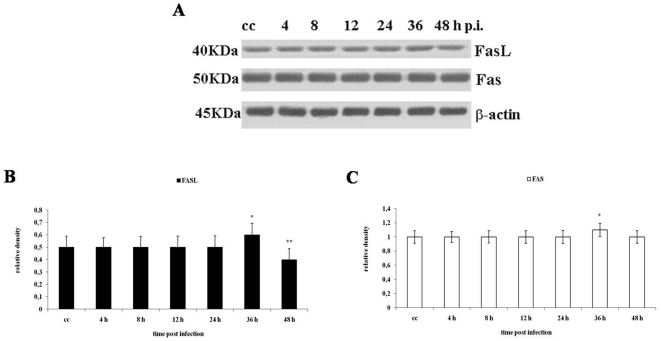
CCoV-II infection modulates FasL/Fas proteins expression.(A) Cell lysates were collected at the indicated times p.i., and equal amounts of proteins from each sample were subjected to Western blot analysis and probed for FasL and Fas. β-actin was used as a loading control. The molecular weight (KDa) of protein size standards is shown on the left hand side. Blot is representative of three separate experiments. (B) Densitometric analysis of blots relative to FasL and (C) Fas. The bars represent the mean ± SEM of the results from three separate experiments. Significant differences between CCoV-II-infected cells and control cells are indicated by probability P. *P <0.05 and **P <0.01.